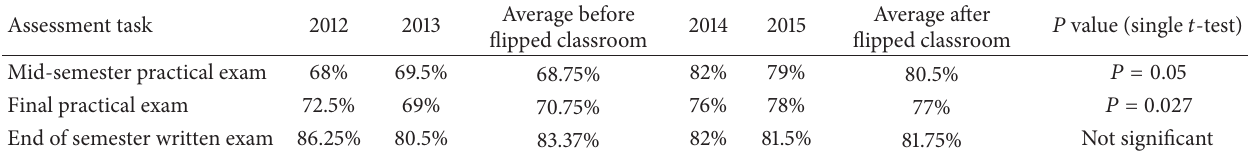
Table 5: Showing a summary of the overall students’ performance in all assessment tasks before and after using the flipped classroom method. Assessment task